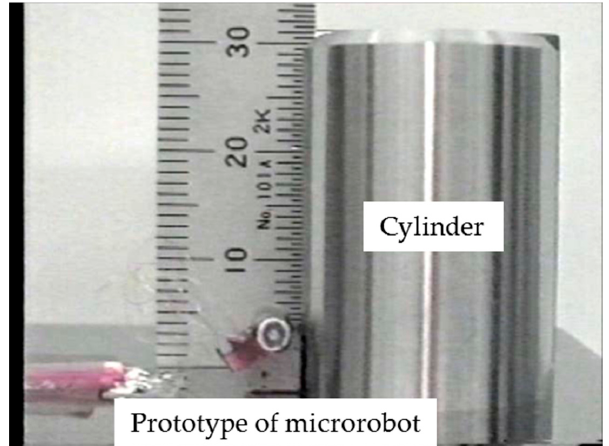
Figure 17. Prototype of a microrobot for evaluating the independent vertical driving performance of a microrobot. A cylinder made of magnetic stainless steel (SUS 430) with a diameter of 22 mm and a height of 30 mm was used in the experiment as a target object simulating a pipe.